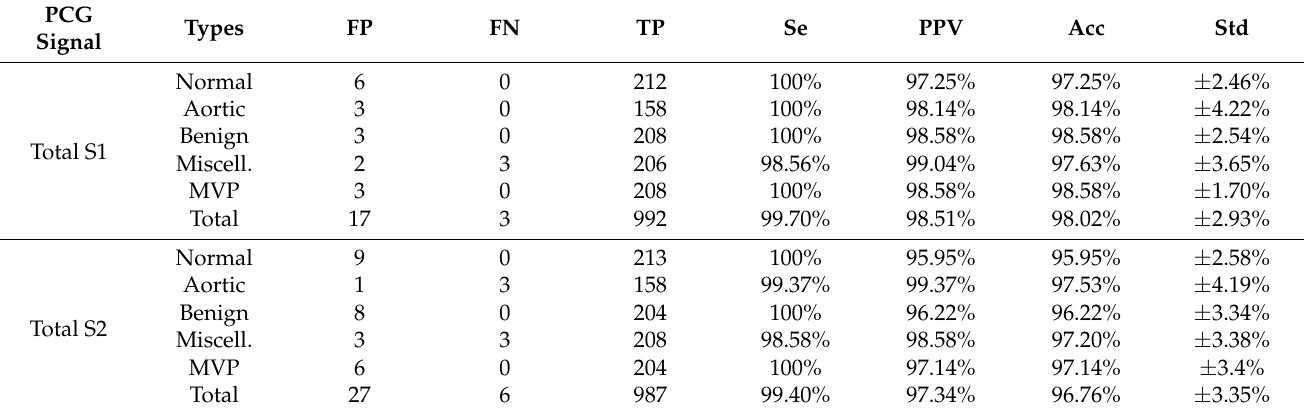
Table 1. Performance of segmentation of heart sounds taken in different